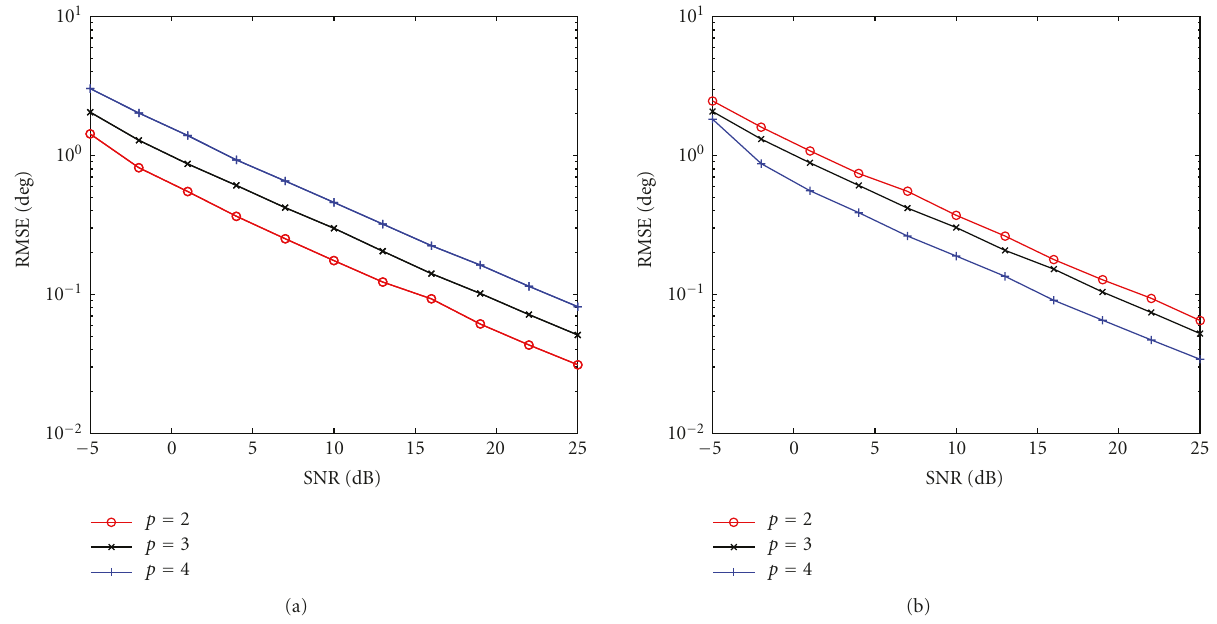
Figure 2: RMSE of 2-D DOA estimation from (55 ◦ , 100 ◦ ) for (a) elevation and (b) azimuth